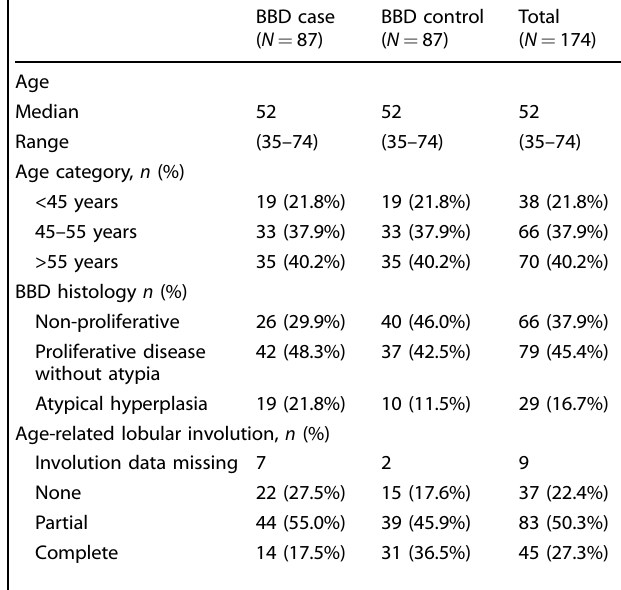
Table 3. Patient Characteristics: Characteristics of patients included in analysis set for this